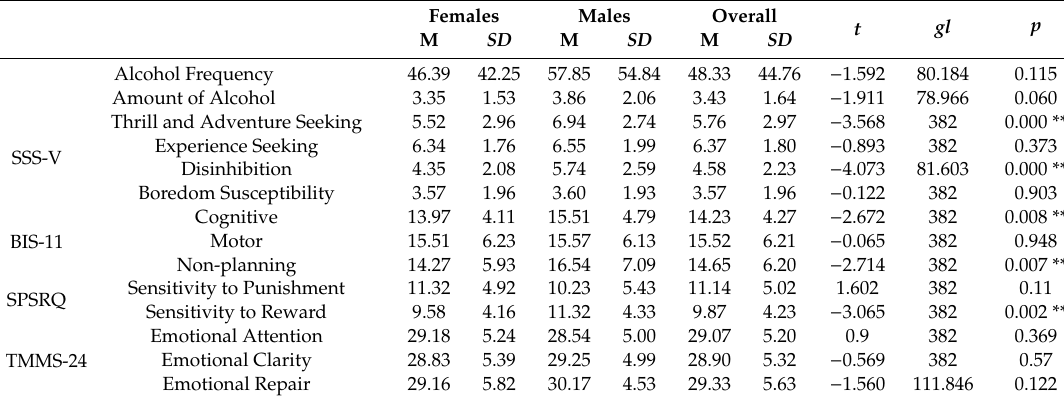
Descriptive statistics and sex di ff erence (Student’s t -test) for personality trait and emotional